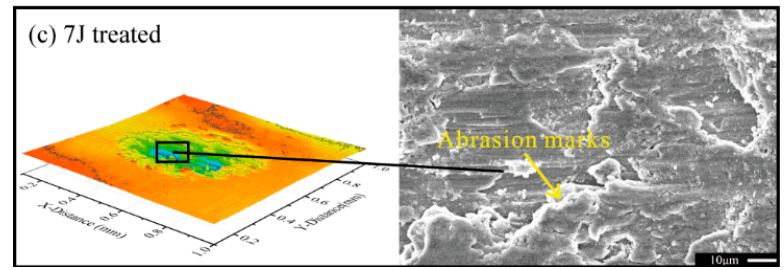
Figure 9. Microstructures of worn scars: N = 3000. ( a ) Untreated; ( b ) 5 J treated; ( c ) 7 J treated.